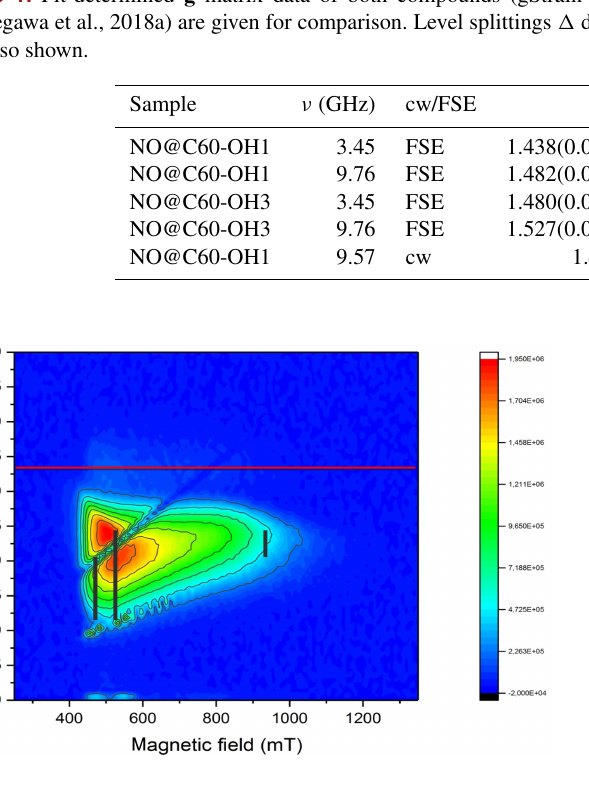
Figure 3. PEANUT spectrum of NO@C60-OH3 measured at 5K. The red line indicates the reference frequency measured for a coal sample with isotropic g = 2. The black vertical lines indicate the expected nutation frequency distributions (Stoll et al., 1998) at the three principal g values for NO@C60-OH3 in Table 1